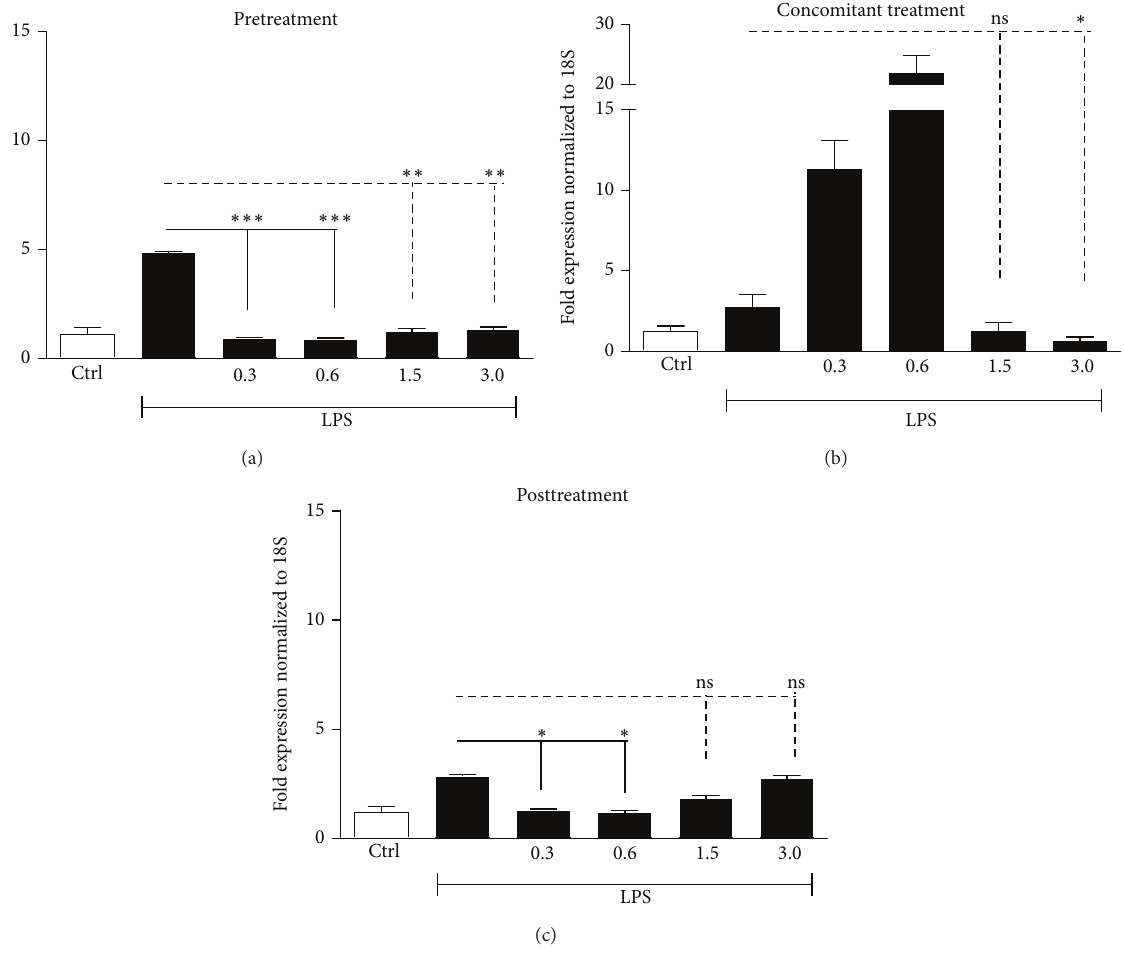
Figure 5: IL-6 gene expression, analyzed through qRT-PCR, in HaCaT cells stimulated with LPS (25 𝜇 g/mL) and incubated in pretreatment, concomitant, and posttreatment settings with low (0.3 mg/ 𝜇 L; 0.6 mg/ 𝜇 L) and high (1.5 mg/ 𝜇 L; 3 mg/ 𝜇 L) doxycycline doses. IL-6 gene expression in (a) cells stimulated with LPS for 24 h and successively incubated with doxycycline for further 24 h, mRNA extraction performed at 48h; (b) cells incubated with doxycycline immediately after LPS, mRNA extraction performed at 24 h; (c) cells pretreated with doxycycline for 24 h and successively stimulated with LPS, mRNA extraction at 48 h ( ∗ 𝑃 < 0.05 , ∗∗ 𝑃 < 0.01 , and ∗∗∗ 𝑃 < 0.001 ; ns: not statistically